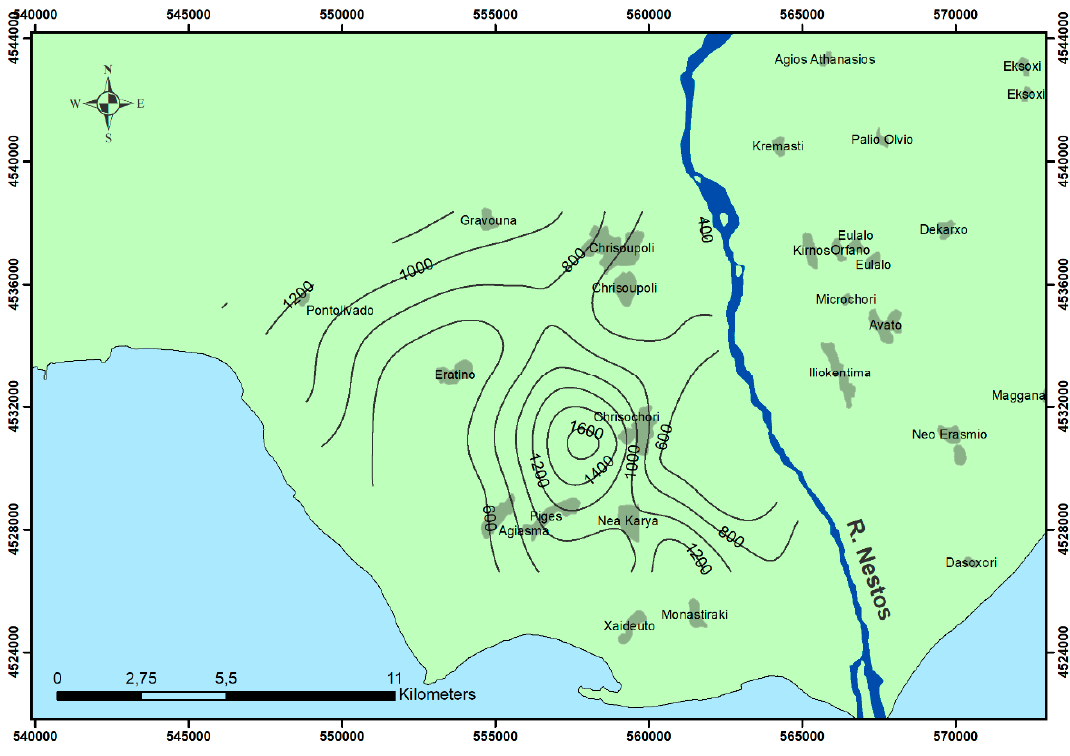
Figure 11. Electrical conductivity distribution map ( μ S/cm) of the confined aquifer (May 2019).